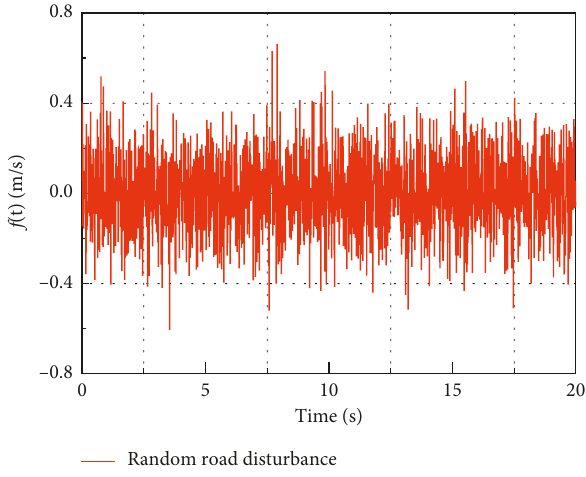
Figure 9: Constraint outputs of the proposed control under the random road